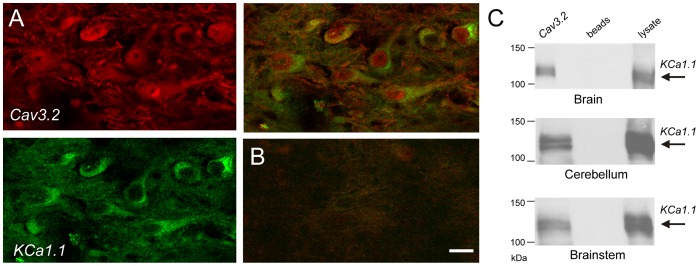
Cav3.2 and KCa1.1 channels associate in rat brain.
A, Dual label immunocytochemistry confirms Cav3.2 and KCa1.1 protein expression in MVN cells with a similar distribution pattern at the level of the soma and at least the proximal dendritic region. B, Control image upon omission of primary antibodies. C, Western blots showing coimmunoprecipitation of Cav3.2 and KCa1.1 protein from lysates of rat brain (n = 4), cerebellum (n = 6), and brain stem (n = 5), with a corresponding label for KCa1.1 in lysates from each region. In lane 1, channel complexes were immunoprecipitated using the Cav3.2 antibody, in lane 2 the precipitating antibody was omitted, and lane 3 corresponds to lysate. All Western blots were probed with anti-KCa1.1. Scale bar in (A, B) = 20 µm.